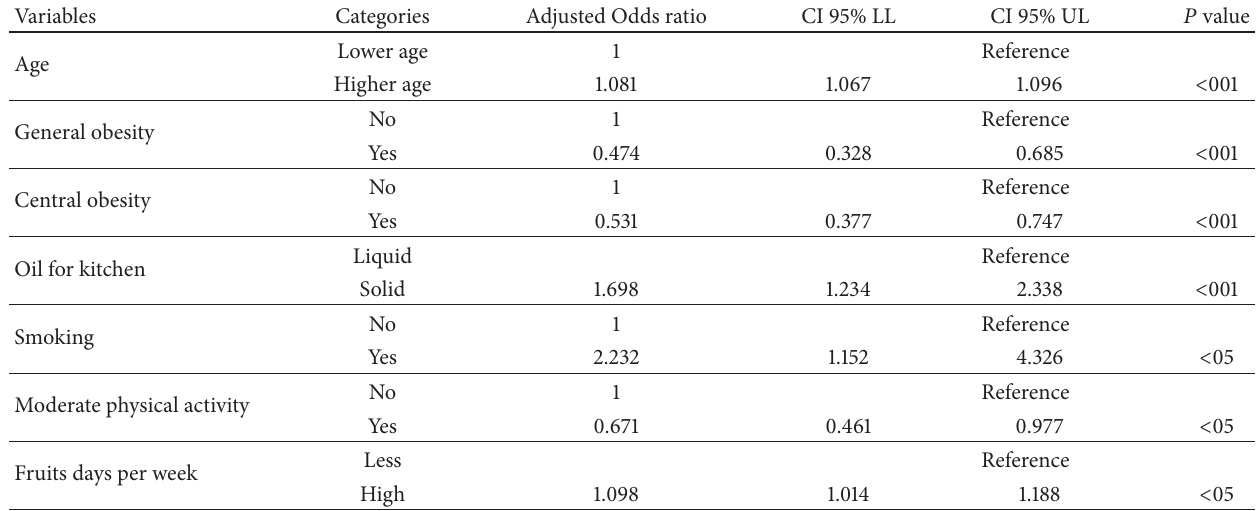
Table 5: Multivariable analysis of risk factors and hypertension among study participants in Kabul city,